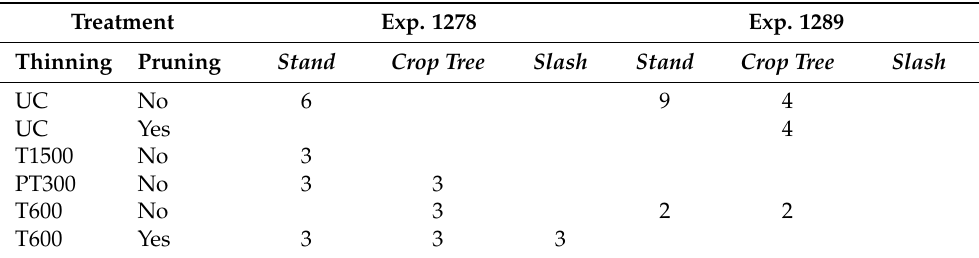
Figure 1. The four thinning treatments: UC = unthinned control, T1500 = moderate thinning mainly from below (N = 1500 ha − 1 at H = 12 m), PT300 = point thinning for 300 pre-selected potential future crop trees per ha, T600 = very heavy thinning (N = 600 ha − 1 after first thinning intervention). Legend: small dot = a tree, large dot = a potential future crop tree. Table 1. Number of research plots used for analyses of stand volume growth, crop tree growth and slash management effects. Nominal thinning treatment indicates the treatment applied during the observation period (exp. 1278: 2011–2019; exp. 1289: 2012–2018) and may deviate from the treatment scheduled for continuation (for example, some unthinned plots in exp. 1289 were pruned in 2012 and thinned in 2018, cf. Table 2 and the main text).